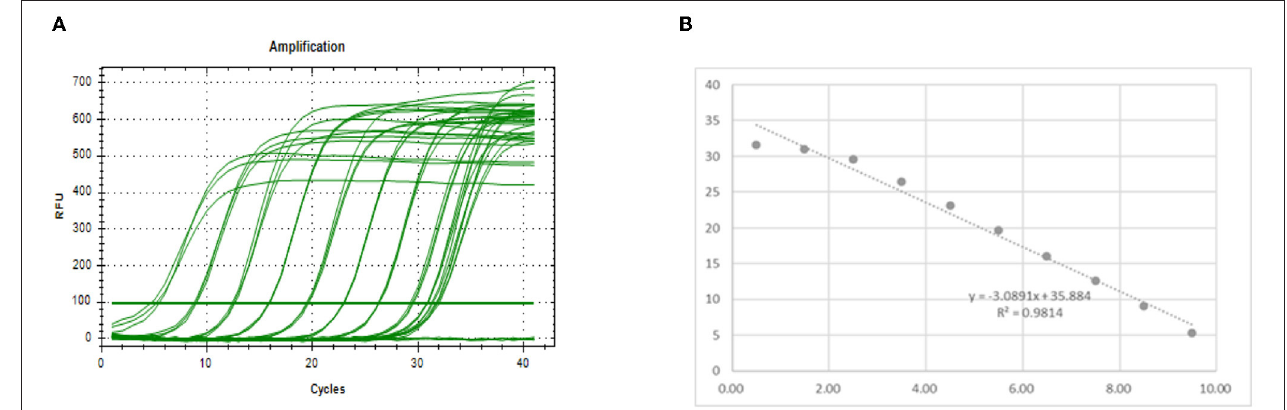
FIGURE 4 | Drawing a standard curve. (A) Amplification curve. (B) Standard curve.